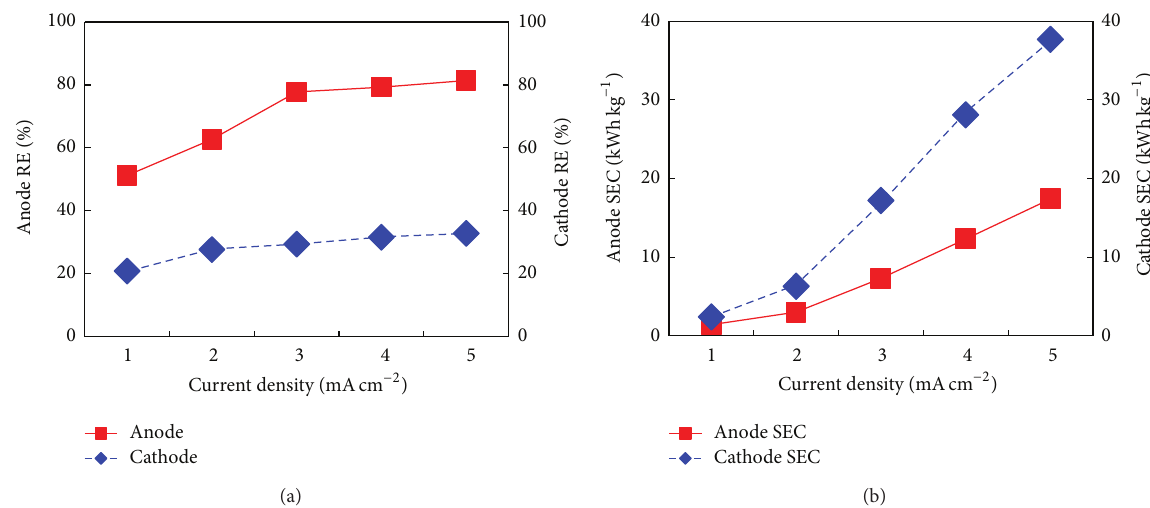
Figure 2: Effect of current density: (a) anodic and cathodic compartment removal efficiency of PVA and (b) SEC of anodic and cathodic compartment removal of PVA (temperature = 323 K, anodic compartment: PVA = 50 mg L −1 , Ce(III) = 0.01 M, HNO 3 = 0.2 M; cathodic